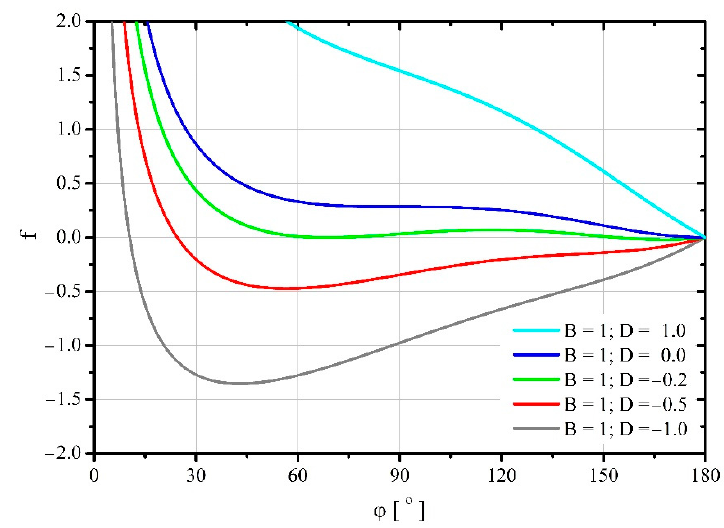
Figure 4. Change of the dimensionless free energy of the system during spreading of the droplet for the parameter 𝐵 = 1 .